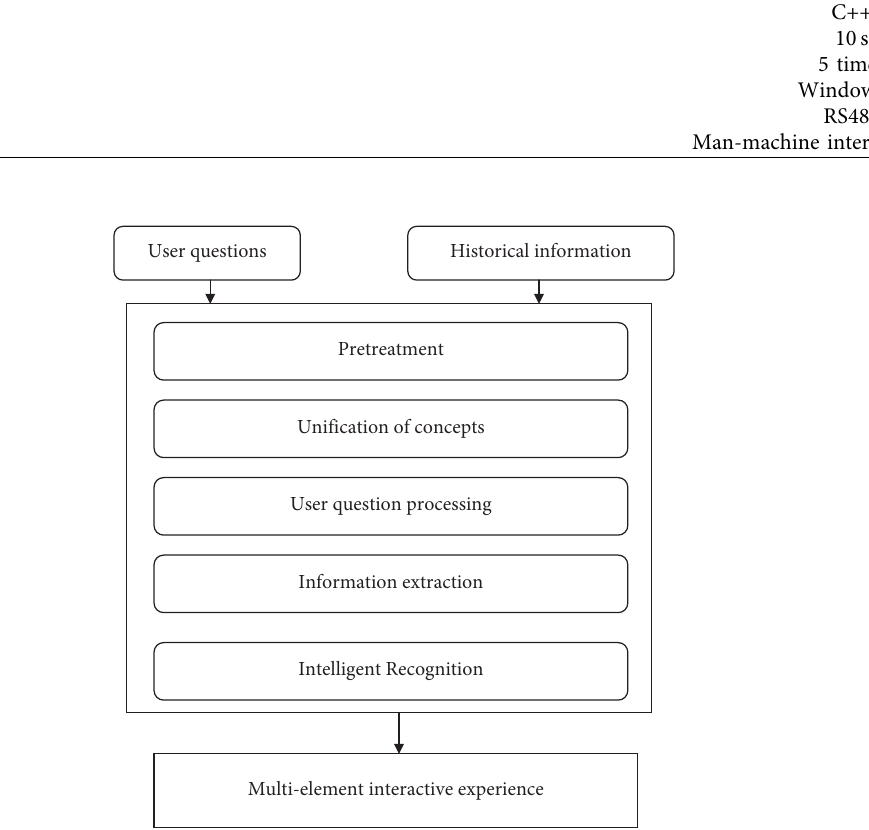
Figure 7: Experimental process